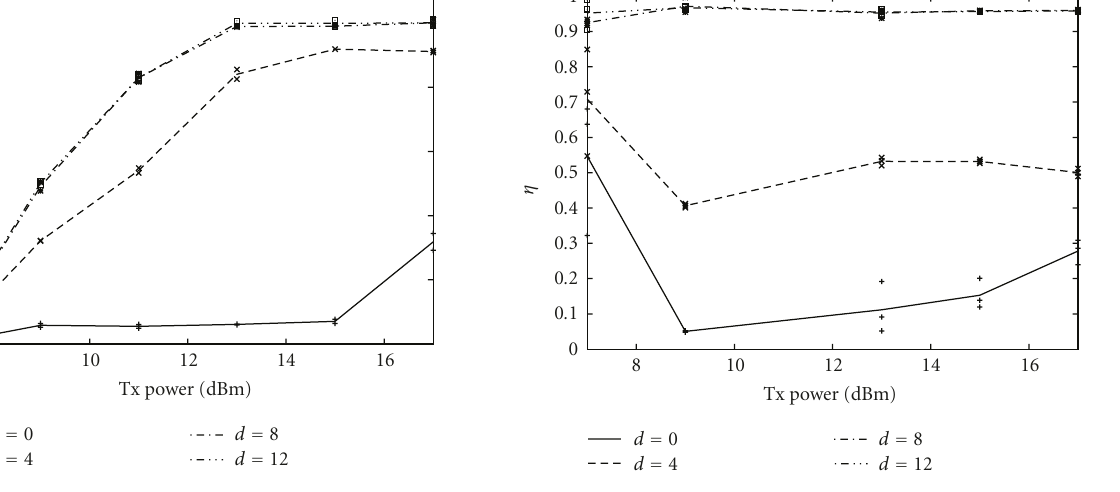
Figure 18: Close links, 802.11a: impact of channel separation and transmitted power on channel e ffi ciency.